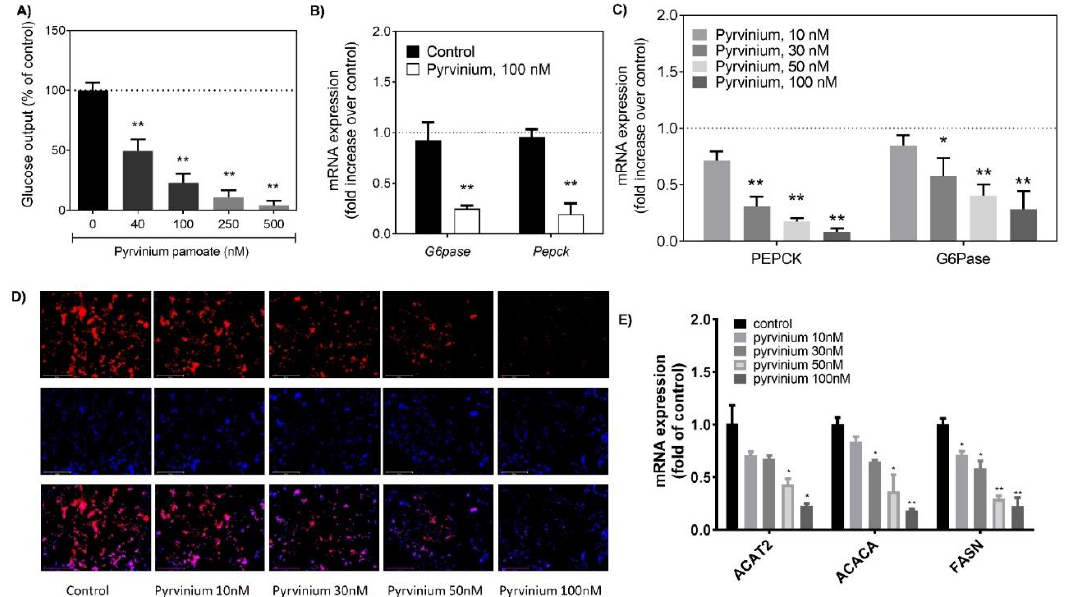
Figure 1. Pyrvinium decreased gluconeogenesis and lipogenesis in hepatocytes. ( A ) Inhibition of pyruvate-induced glucose production in primary mouse hepatocytes by pyrvinium. Cells were treated with pyrvinium for 24 h, then fasted for 4 h prior to glucose production assay. ( B ) Inhibition of gluconeogenic gene expression in mouse primary hepatocytes incubated with pyrvinium 100 nM for 24 h. ( C ) Relative mRNA expression of gluconeogenic genes PEPCK and G6Pase in Huh7 cells treated with pyrvinium for 24 h in the medium containing 1g/L glucose. ( D ) Representative images of Nile red staining for lipids in Huh7 cells. The cells were treated with indicated concentrations of pyrvinium for 36 h and then together with 200 µ M oleate for 16 h. The scale bar is 275 µ m ( E ) Relative mRNA expression of lipogenic genes ACAT2 , ACACA , and FASN in Huh7 cells treated with pyrvinium for 24 h. * p < 0.05; ** p < 0.01. Data are representative of at least three independent studies.